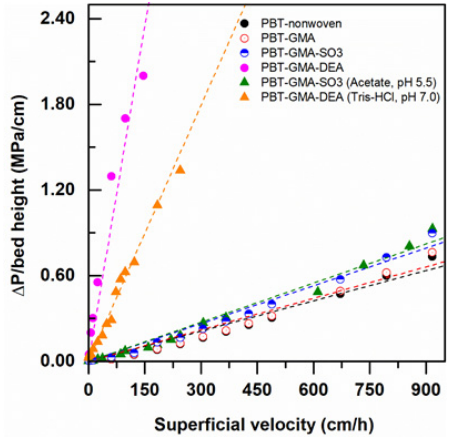
Figure 4. Water and 20 mM buffer pressure drop normalized with membrane bed height versus superficial flow velocity in a 2.5 cm diameter column packed with 12 layers of nonwoven membranes at a bed height of 0.30 cm.